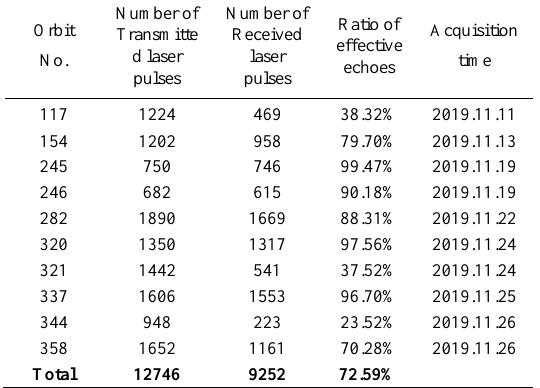
Table 2. Orbital number, number of laser points and